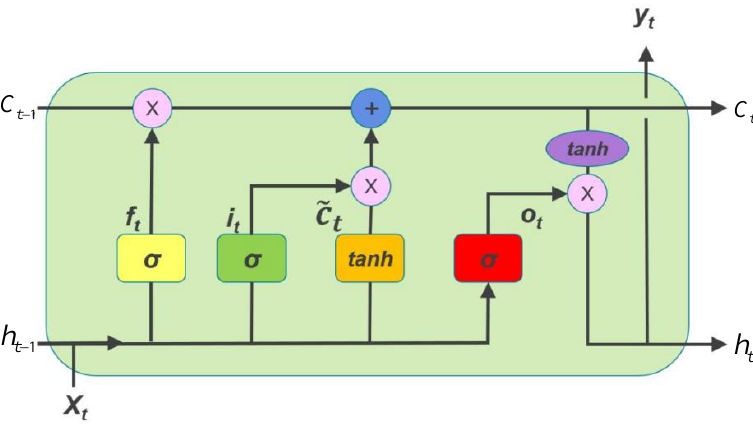
Figure 6. LSTM unit internal structure diagram.